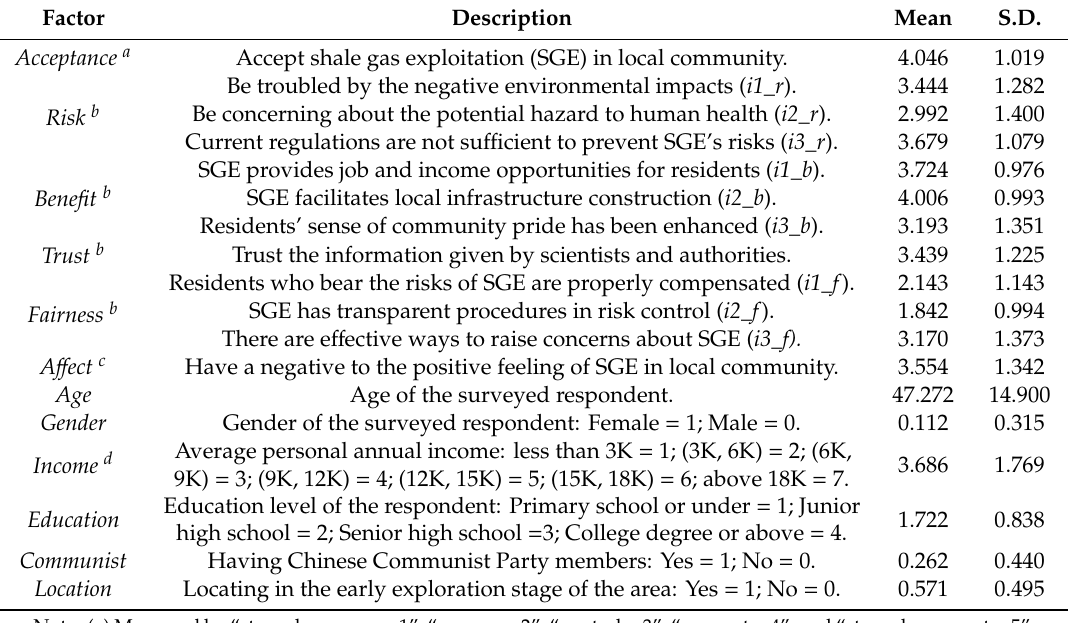
Table 1. Definitions and descriptive statistics of variables for model